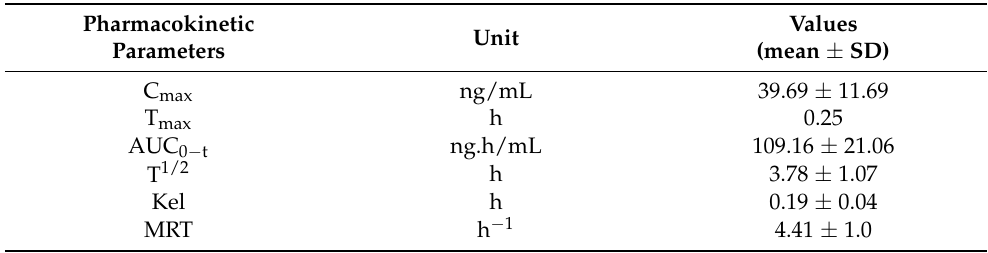
Table 6. Pharmacokinetic parameters of LEM in male rats ( n = 6) after single dose administration (10 mg/kg p.